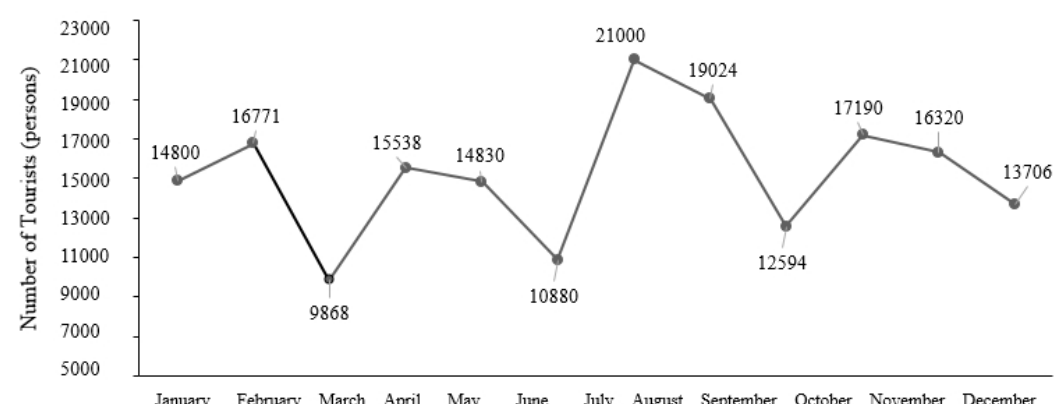
Figure 5. Huisun Forest Park monthly 2016–2017 average number of tourists.